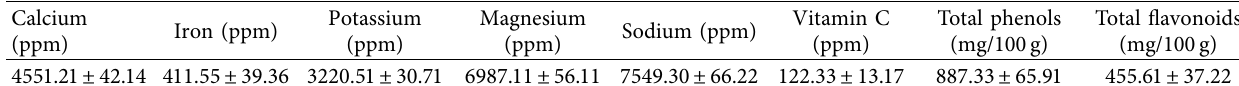
Data are expressed as mean values ± standard deviations. Table 3: Some minerals, vitamin C, total phenols, and total flavonoids of chard (dry weight basis).